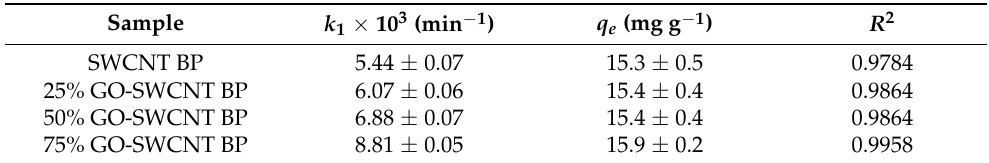
Table 2. Lagergren adsorption rate constant, k 1 (min − 1 ), and lead adsorption capacity per unit of adsorbent mass at equilibrium, q e (mg g − 1 ), for BPs with different GO loading.